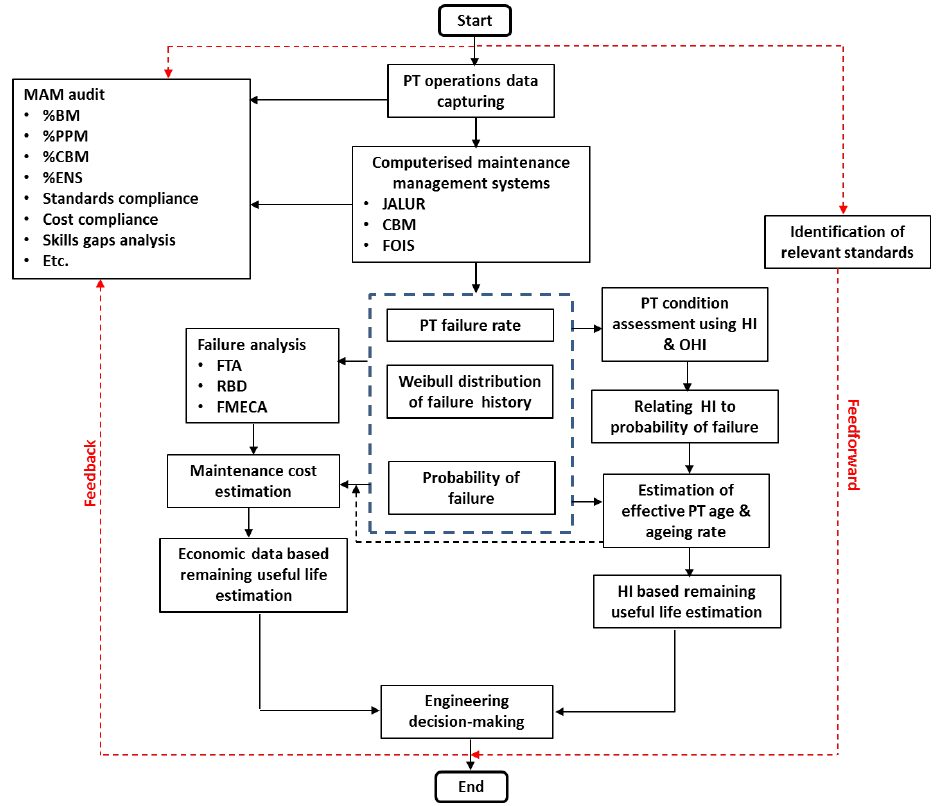
Figure 5. Integrated engineering decision-making framework for PT.